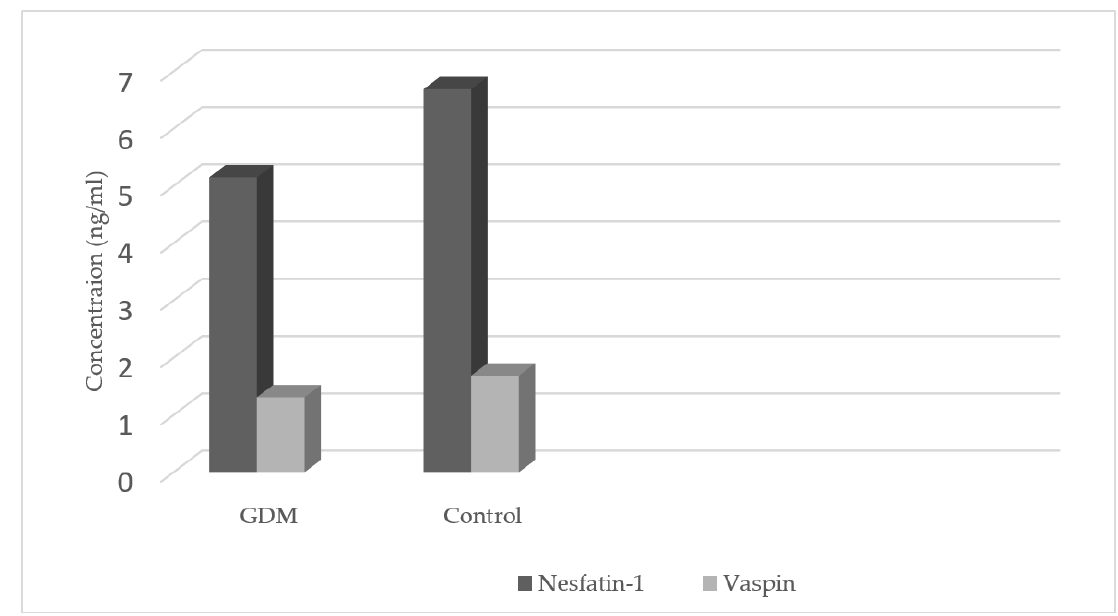
Figure 1. Nesfatin-1 and vaspin concentrations in the GDM and control groups. Table 3. Correlation between nesfatin-1, vaspin levels, and maternal age, gravidity, body